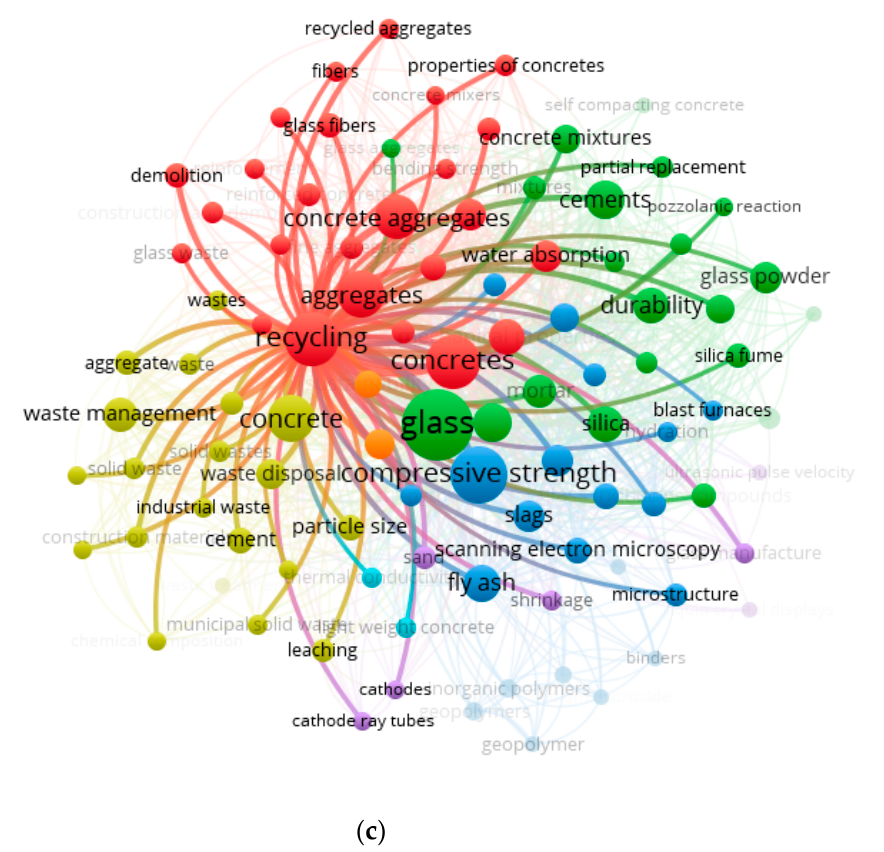
Figure 6. Connection of a keyword with others: ( a ) glass; ( b ) waste management; ( c ) recycling.